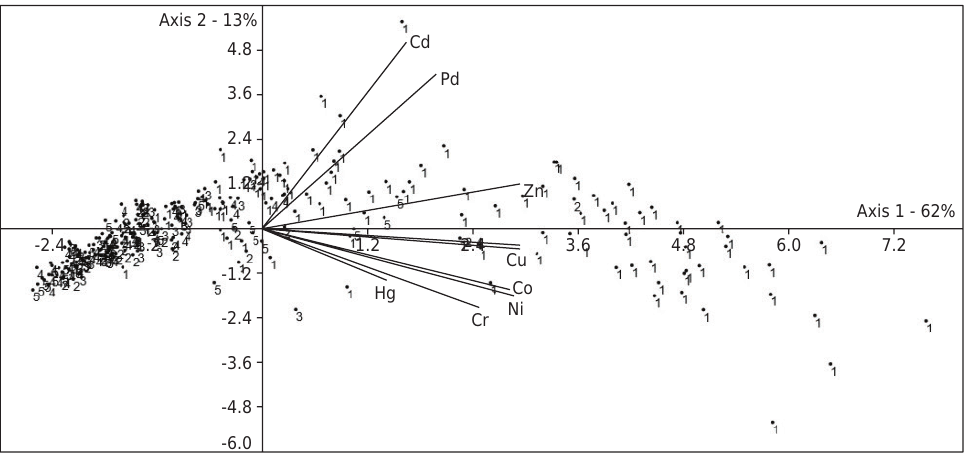
Figure 4. Ordination diagram obtained by principal component analysis for metals and soil groups, according to table 1. The metals are represented by vectors and soil groups by dots.